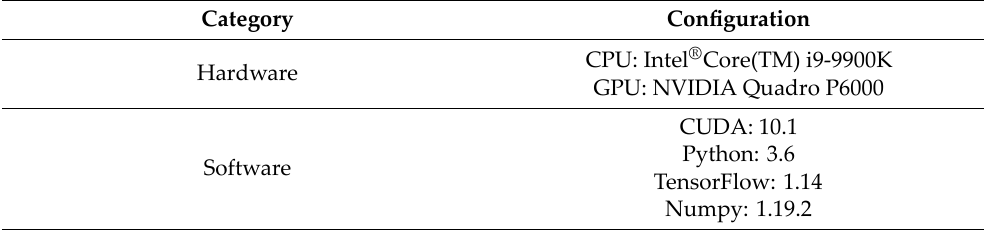
Table 6. Experimental